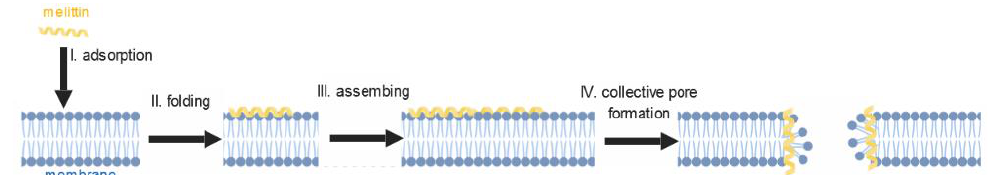
Figure 1. Scheme of pore formation in membrane by melittin.